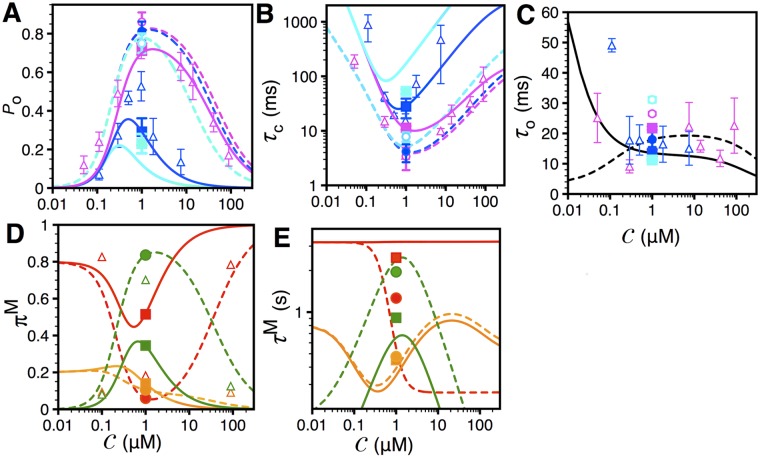
Mean gating properties of IP3R in the presence of PS1-WT and PS1-M146L.Experimental values are shown by symbols (filled symbols for data that are used to derive the parameters for our model, open symbols for data not used for parameter derivation), theoretical values calculated from the twelve-state model using corresponding parameters are shown by lines. Mean P
o (A), τ
c (B), and τ
o (C) of IP3RPS1WT (solid lines and squares) and IP3RPS1M146L (dashed lines and circles) at 𝓘 = 33nM, 100nM, and 10μM (in turquoise, blue, and magenta, respectively) as functions of 𝓒. Data for 𝓘 = 100nM (blue symbols) were published in [15], and data for 𝓘 = 33 nM and 10 uM (turquoise and magenta symbols, respectively) were published in [14]. (C) Because experimental τ
o values did not show any strong systematic trend as 𝓘 varied (from 33 nM through 100 nM to 10 μM), theoretical values of τ
o generated by the models for all 𝓘 (33nM, 100 nM or 10 μM) are the same (shown in black, solid line for IP3RPS1WT and dashed line for IP3RPS1M146L). Prevalences (D) and life-times (E) of the three gating modes (red, orange, and green for L, I, and H modes, respectively) of IP3RPS1WT (solid lines and squares) and IP3RPS1M146L (dashed lines and circles) as a function of 𝓒 at 𝓘 = 100nM. In (D), the open triangles are data for IP3RnoPS1 at saturating 𝓘 = 10μM [21] showing that modal prevalences of IP3RPS1M146L at 𝓘 = 100 nM are similar to those of IP3RnoPS1 at 𝓘 = 10μM. Error bars represent standard error of the mean.